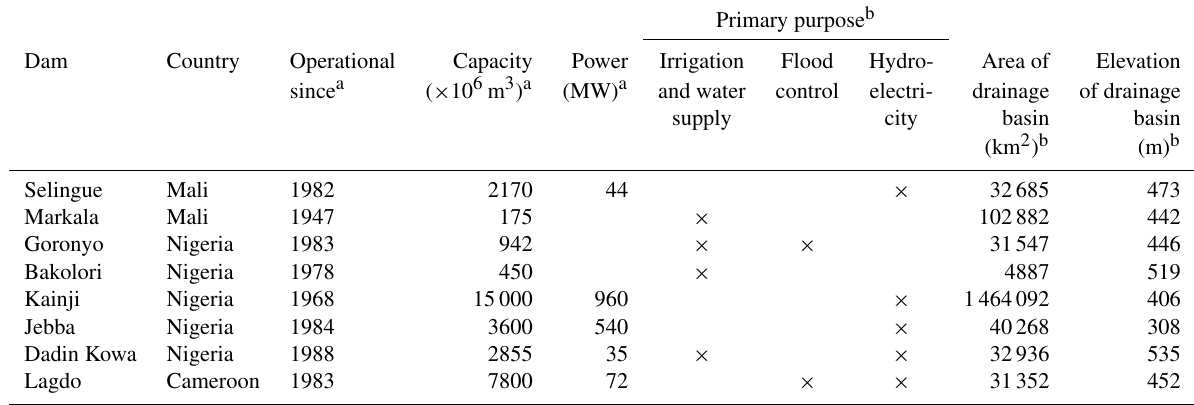
Table 1. Selected dams and their watershed characteristics.